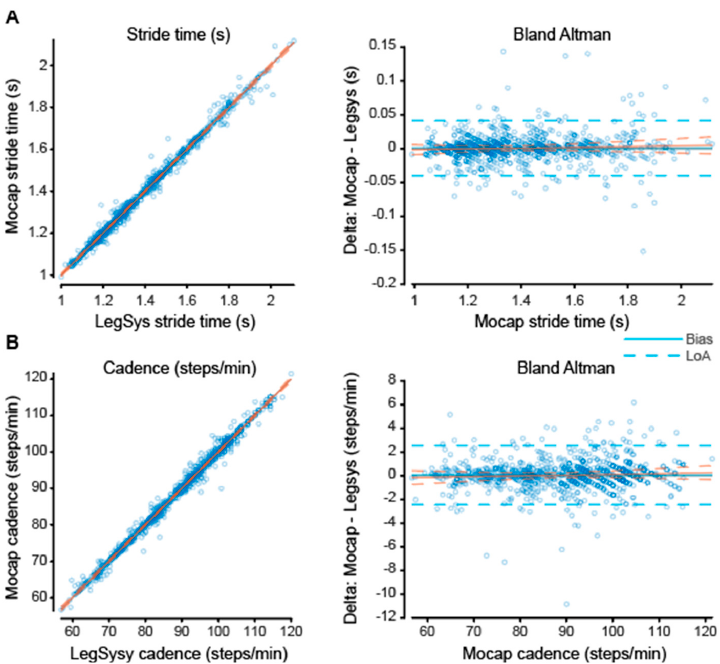
Figure 5. Scatter and bland-Altman plot of MOCAP vs. LEGSYS for stride time (sec) and cadence (steps/min). Part ( A , B ) shows the scatter plot and bland-Altman plot on the left and right, respectfully for each parameter. For the scatter plot, the blue dots show stride length or stride velocity for each system. The bland-Altman plots show the difference between the MOCAP and LEGSYS parameters on the Y axis and MOCAP stride length or velocity. Blue line and dotted blue line show the bias and limits of agreement respectfully. The orange line on all 4 plots shows the least squares regression lines with orange dots being the 95% confidence interval. Table 2. Mocap gait parameters prediction